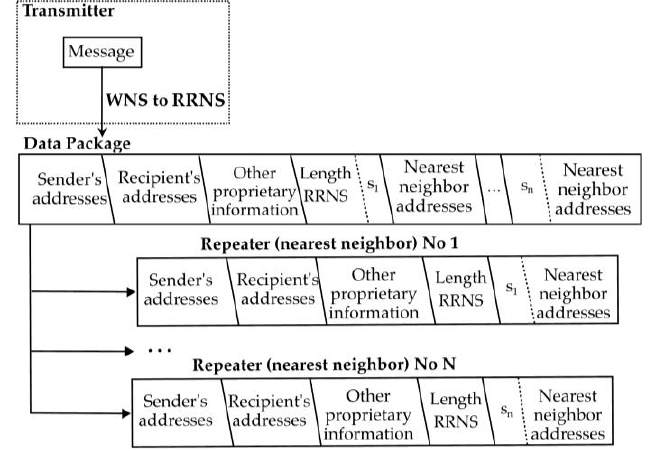
Figure 3. Data packet